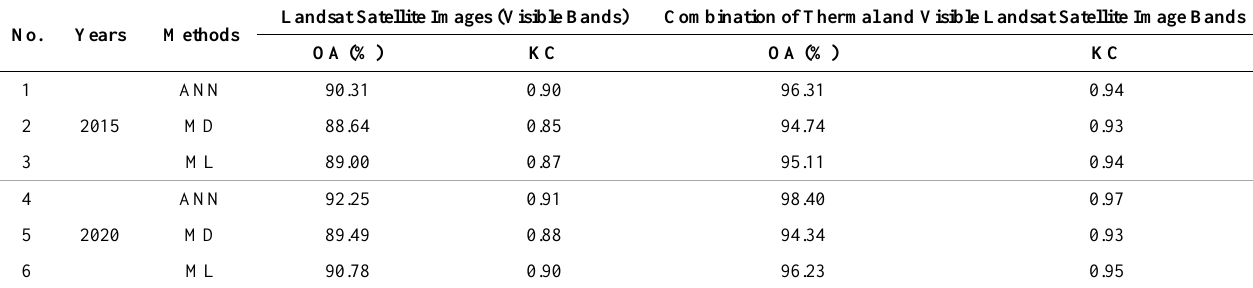
Table 4. OAs and KCs of the MD, ANN, and ML approaches applied to the Landsat images of 2015 and 2020 No. Years